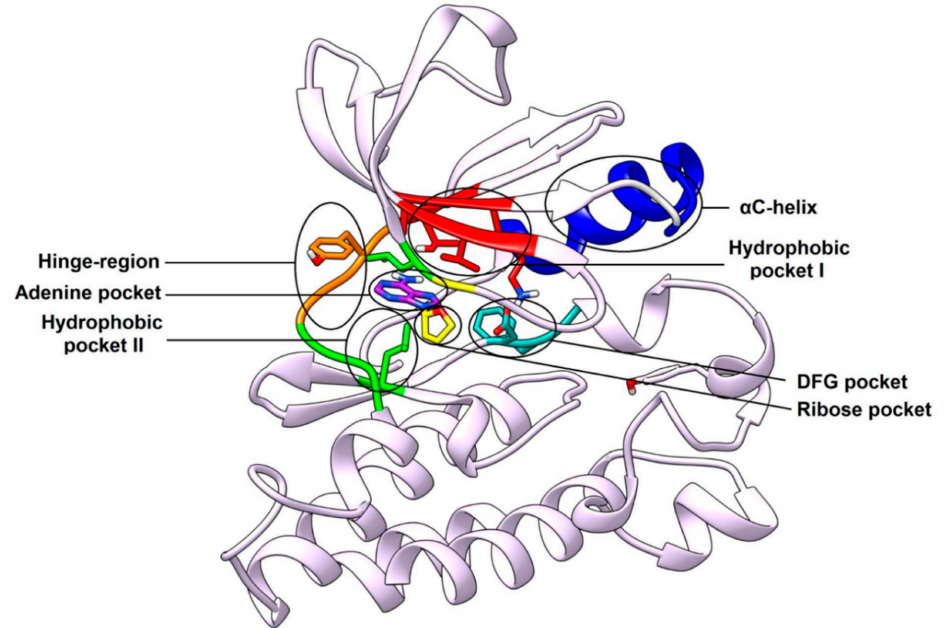
Figure 2. X-ray complex of inactive c-Src kinase showing the catalytic domain between N-terminal and C-terminal lobes, highlighted by di ff erent binding pockets. The DFG motif and the α C-helix are highlighted in cyan and blue,